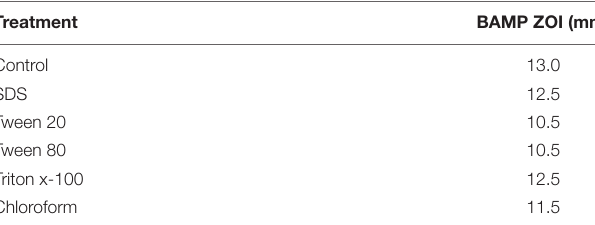
TABLE 2B | Effect of surfactants and chloroform on the activity of BAMP. Treatment